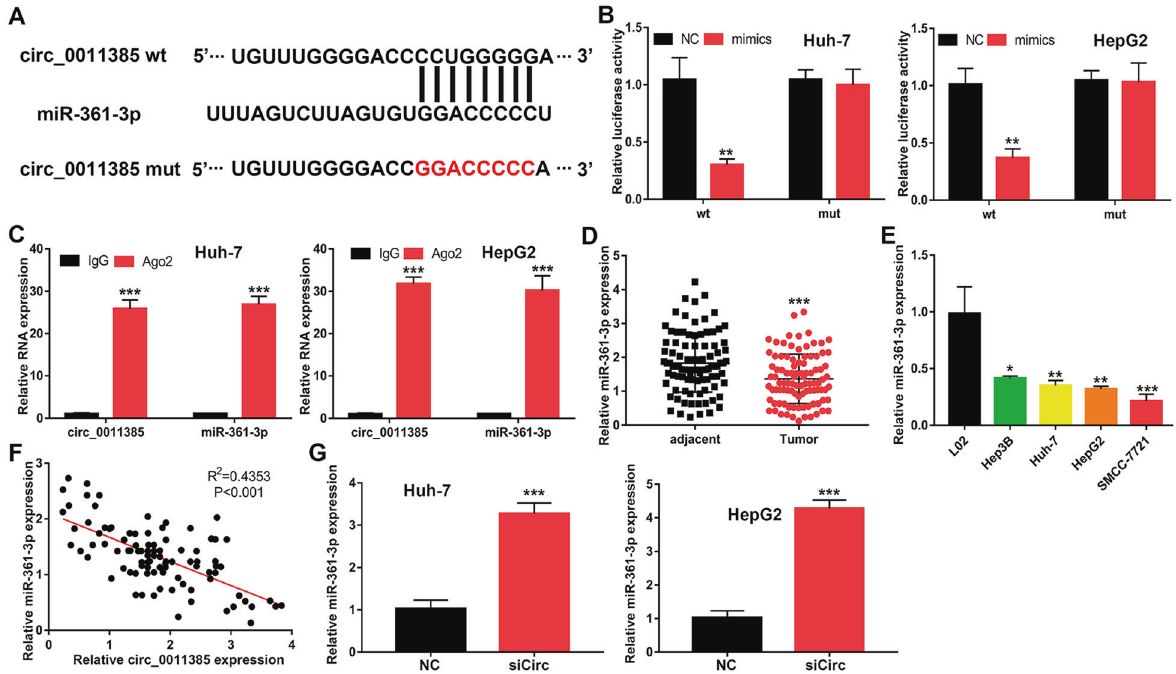
Fig. 3 miR ‐ 361-3p is the target of circ_0011385. A Bioinformatics tools indicated the complementary binding sites of miR ‐ 361-3p and circ_0011385. B Luciferase reporter assays showing the targeting of miR ‐ 361-3p with circ_0011385 in Huh-7 and HepG2 cells. C RIP and qRT- PCR assays measuring the expression differences in circ_0011385 and miR-361-3p in Huh-7 and HepG2 cells. D Relative miR-361-3p expression in HCC tissues and adjacent tissues. E Relative miR-361-3p expression in HCC cells and L02. F Correlation between miR ‐ 361-3p and circ_0011385, calculated with Spearman ’ s rank correlation coef fi cients. G qRT ‐ PCR of miR-361-3p expression after circ_0011385 knockdown in Huh-7 and HepG2 cells. Data ( n = 5) are the means ± SD. *P < 0.05, ** P < 0.01, *** P < 0.001.